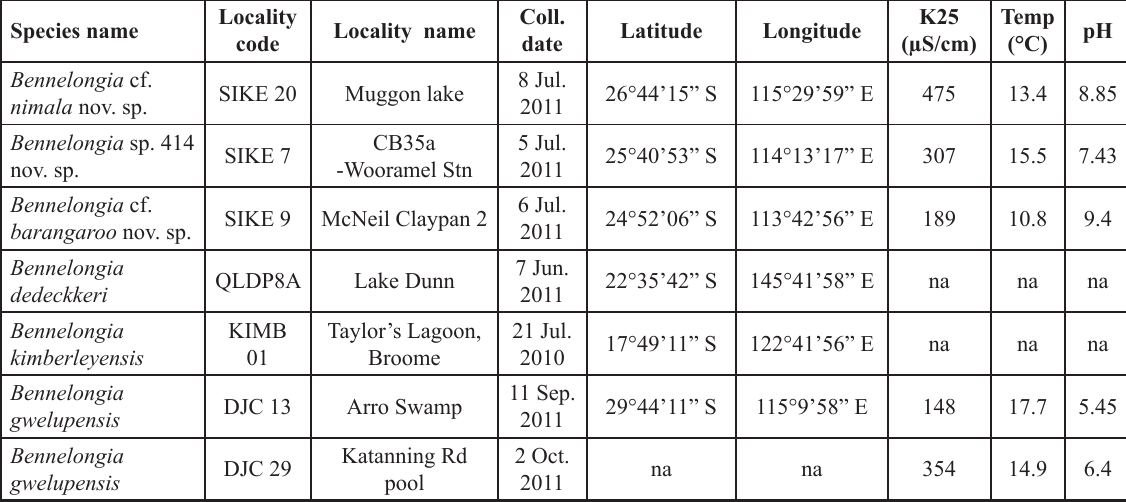
Table 1. List of species studied here and information on their respective